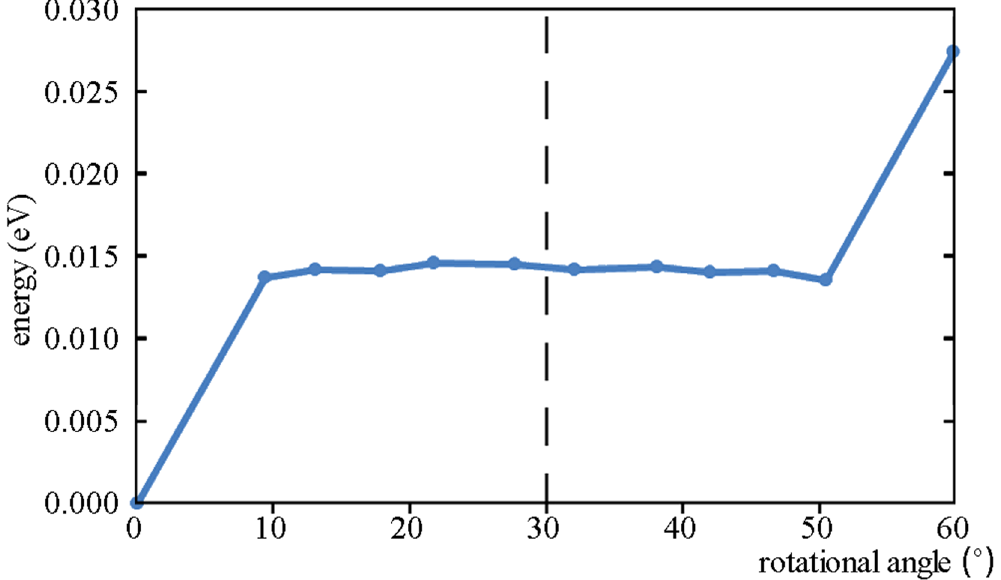
Figure 7. The dependence of the rotational energy per formula unit required to rotate bilayer structure on the RSF rotational